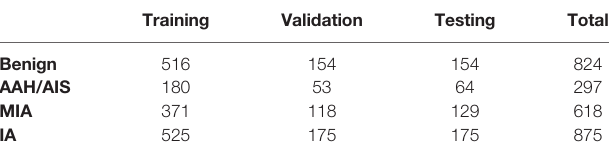
TABLE 2 | Distribution of SSN subtypes on each dataset.